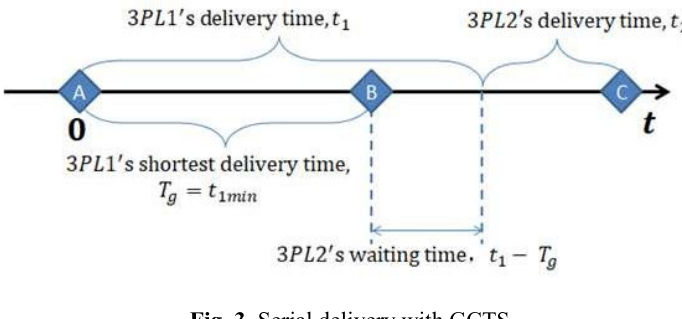
Fig. 3. Serial delivery with GCTS